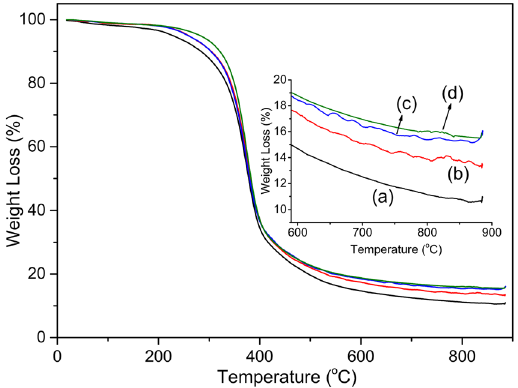
Figure 11. TGA traces of PPOB 40 -B-al 40 -S 20 ( a ), 1 st ( b ), 3 rd ( c ) and 5 th ( d ) healing cycles.